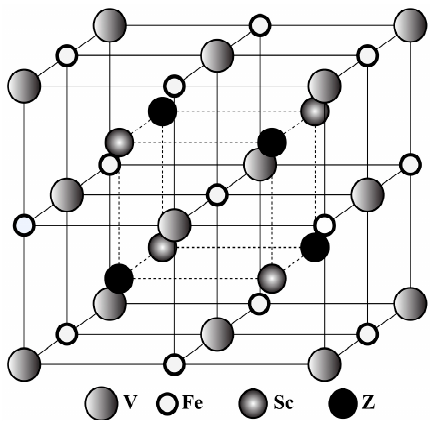
Figure 2. Type-I structure of the quaternary alloy VFeScZ (Z = Sb, As, P). Table 1. Ground state energy ( E , eV), lattice constant ( L , Å), and magnetic moment ( M , µ B ) of type-I, -II, and -III structures of VFeScZ (Z = Sb, As, P).